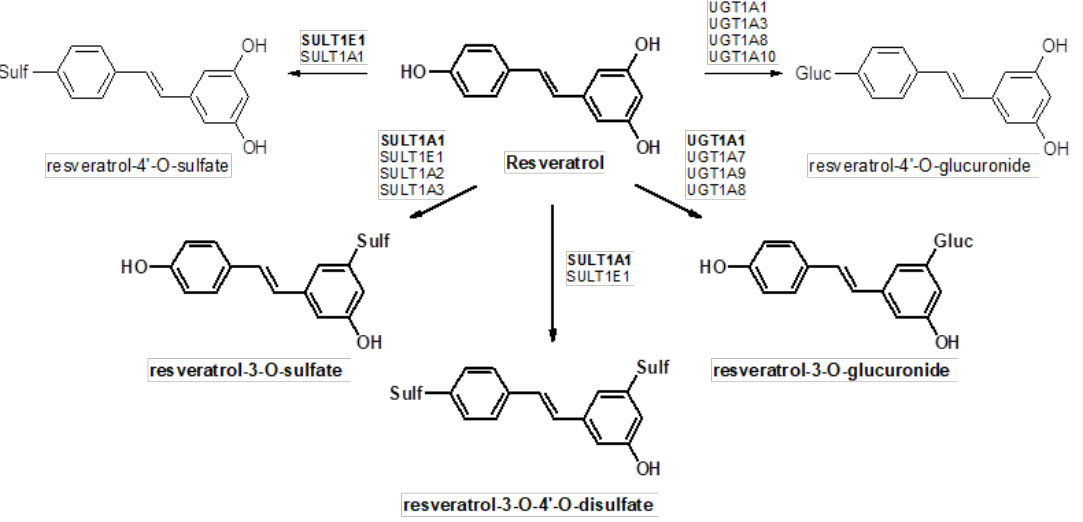
Figure 1. Formation of resveratrol metabolites by various UDP-glucuronosyltransferases (UGTs) and cytosolic sulfotransferases (SULTs) in humans. Conjugates in bold represent the main metabolic